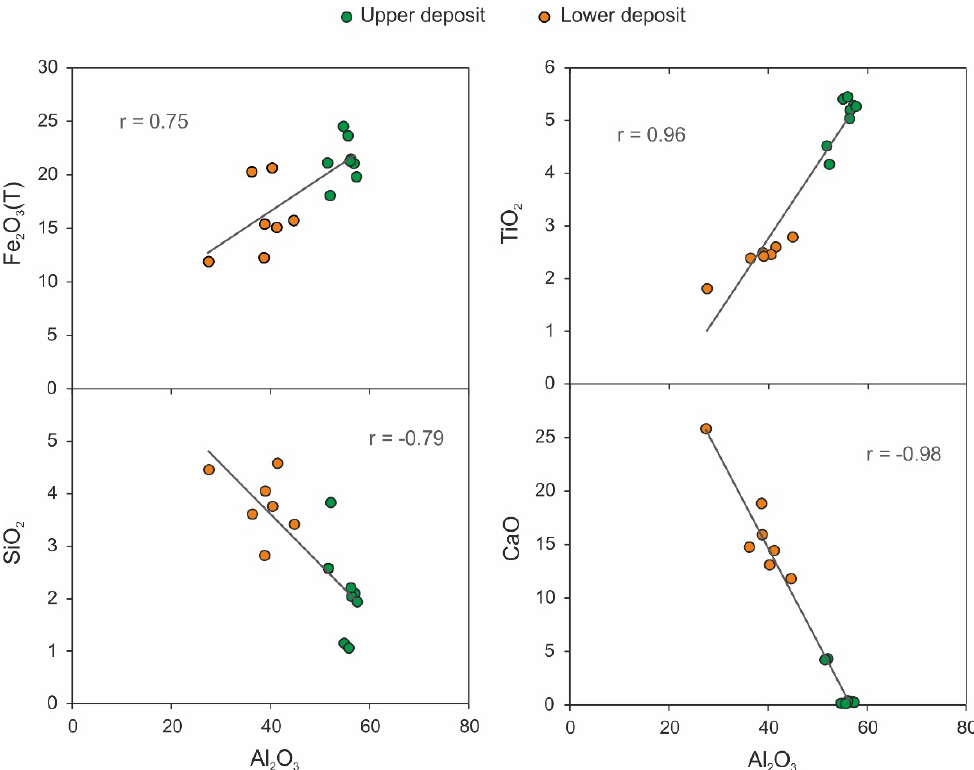
Figure 6. Plots of Al 2 O 3 versus Fe 2 O 3 , SiO 2 , TiO 2 , and CaO with the correlation coefficient (r). See text for further details.